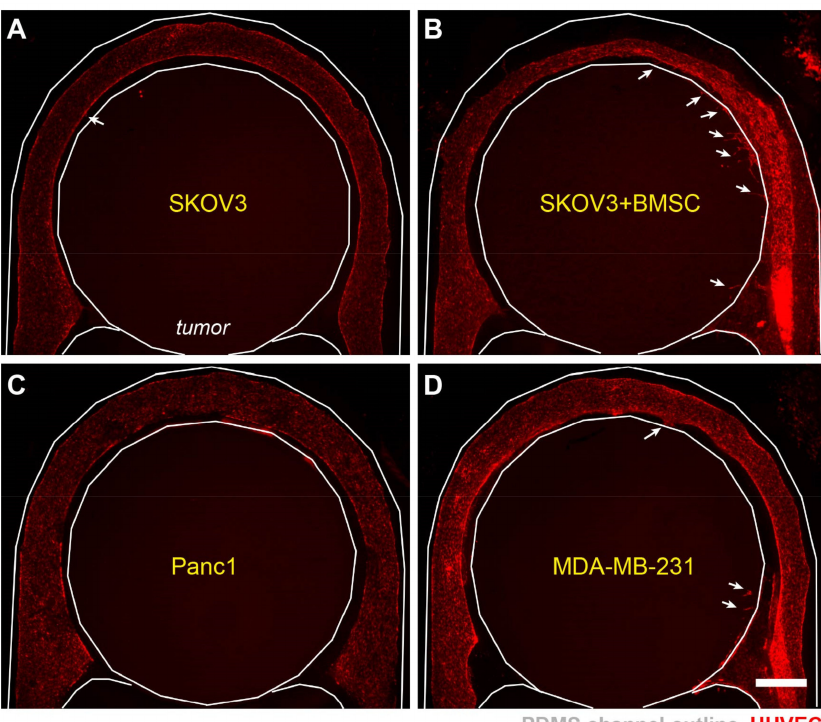
Figure 6. Differential angiogenic responses in different tumor models. Vascularized hypoxic tumor models on day 7 with ( A ) SKOV3 cells, ( B ) SKOV3+BMSCs, ( C ) Panc1 cells, and ( D ) MDA-MB-231 cells in the tumor sections. White arrows: incidence of vascular sprouting. Scale bars: 1 mm.